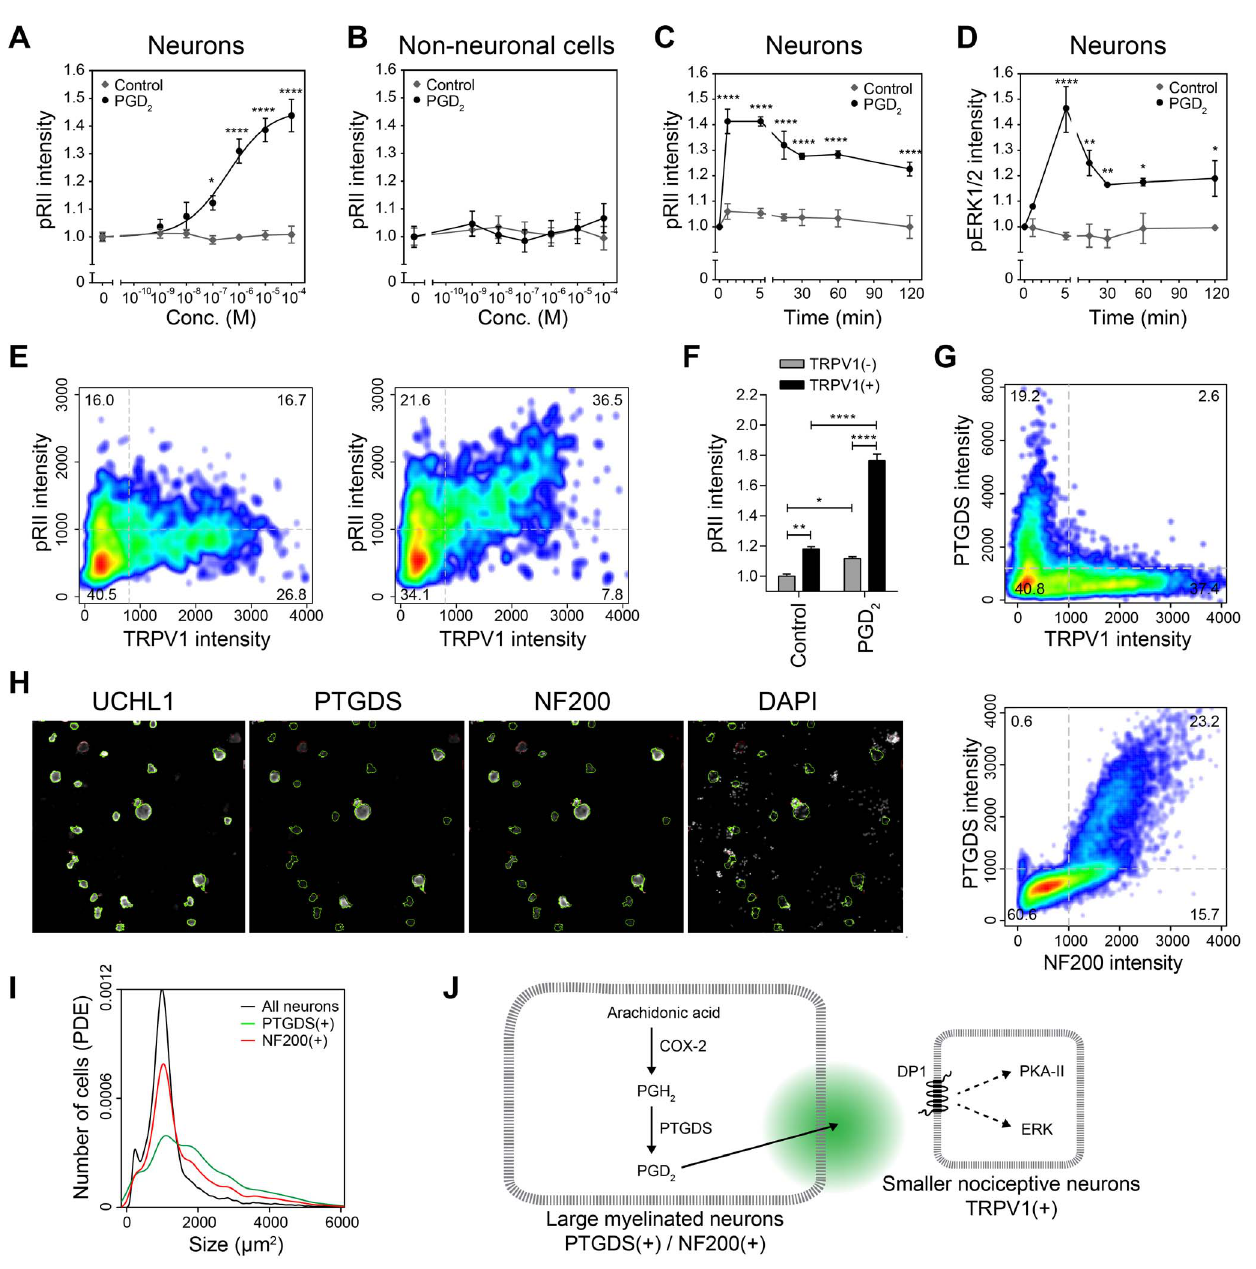
Fig. 5. PGD 2 is a paracrine mediator synthesized in myelinated large-diameter neurons that acts on TRPV1( + ) neurons. (A)Dose-dependentinduction of RII phosphorylation in sensory neurons after 1 min stimulation with PGD 2 (EC 50 5 377 nM, n 5 3, . 2000 neurons/condition; one-way ANOVA with Bonferroni’s multiplecomparisonstest).(B)PGD 2 didnotinducepRIIinnon-neuronalcellsofthesameculturesshowninA.(C)TimecourseofRIIphosphorylationindicatinglong- lastingeffectsofPGD 2 (10 m M)onsensoryneurons.(D)StimulationwithPGD 2